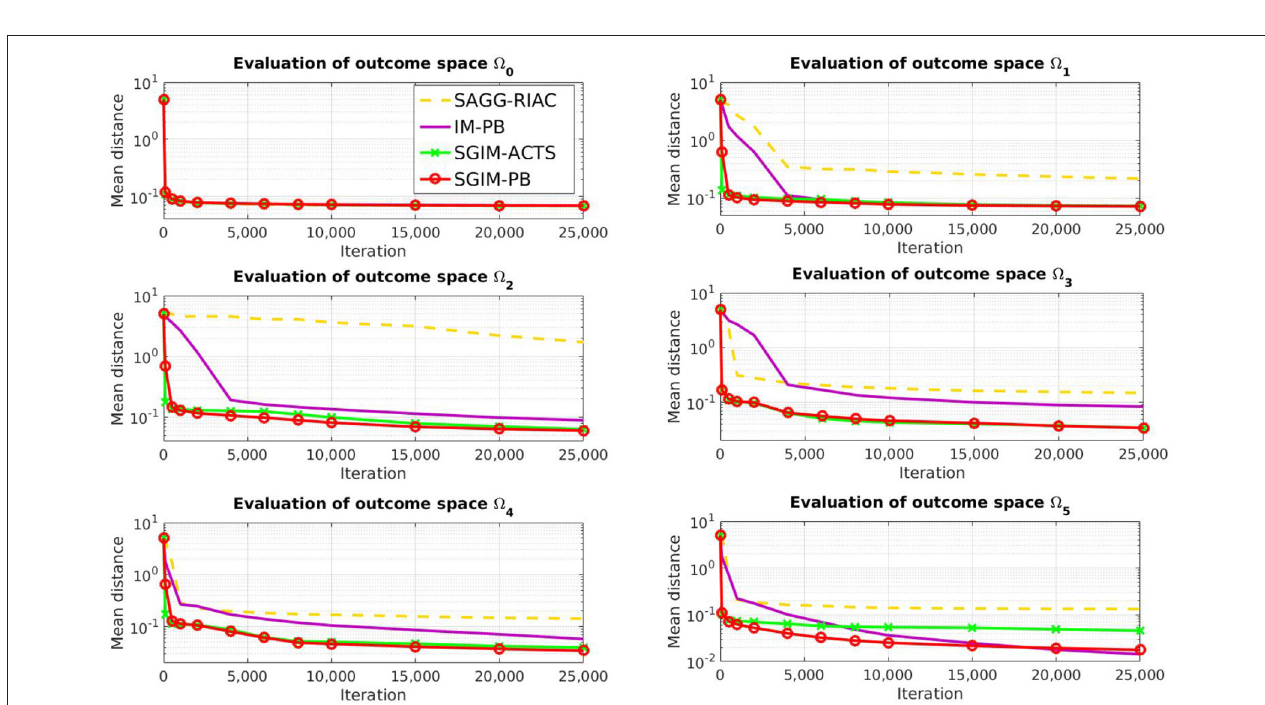
FIGURE 5 | Evaluation of all algorithms per outcome space (for (cid:127) 0 , all evaluations are superposed).